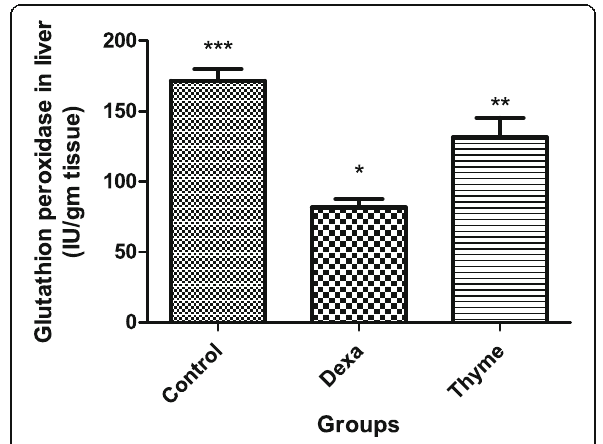
Fig. 9 The defensive role of thyme aqueous extract on liver glutathione peroxidase activity in normal and dexamethasone (DXM)-treated rats. Percentage changes (%) were calculated by comparing normal group with DXM-treated group and pre-treated DXM groups with DXM-treated group.